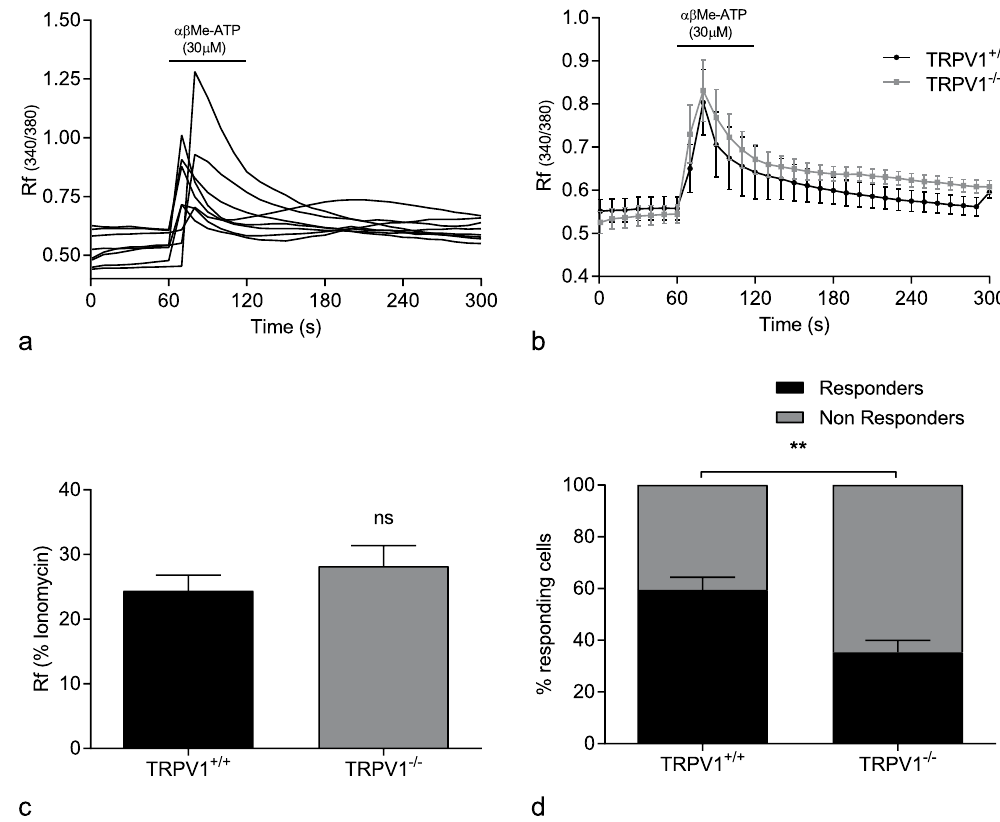
Figure 4. The role of TRPV1 in DRG responses to P2X agonists. ( a ) Individual DRG neurons respond to αβ Me-ATP (30 µ M), applied for 60 s before washout, with an increase in intracellular calcium; ( b ) mean response of DRGs to αβ Me-ATP (30 µ M) from TRPV1 + / + and TRPV1 − / − mice; ( c ) peak intracellular calcium response of DRGs to αβ Me-ATP (30 µ M) from TRPV1 + / + and TRPV1 − / − mice; ( d ) percentage of DRG neurons responding (black bar) and non-responding (grey bar) to αβ Me-ATP (30 µ M); Data shown are mean ± SEM, two-tailed unpaired t-test ns p ≥ 0.05, ** p ≤ 0.01 (n = 12, N =